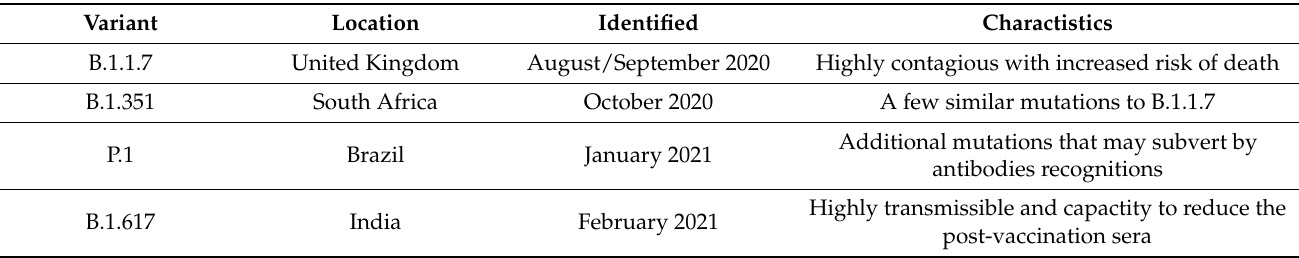
Table 1. List of important SARS-CoV-2 variants and